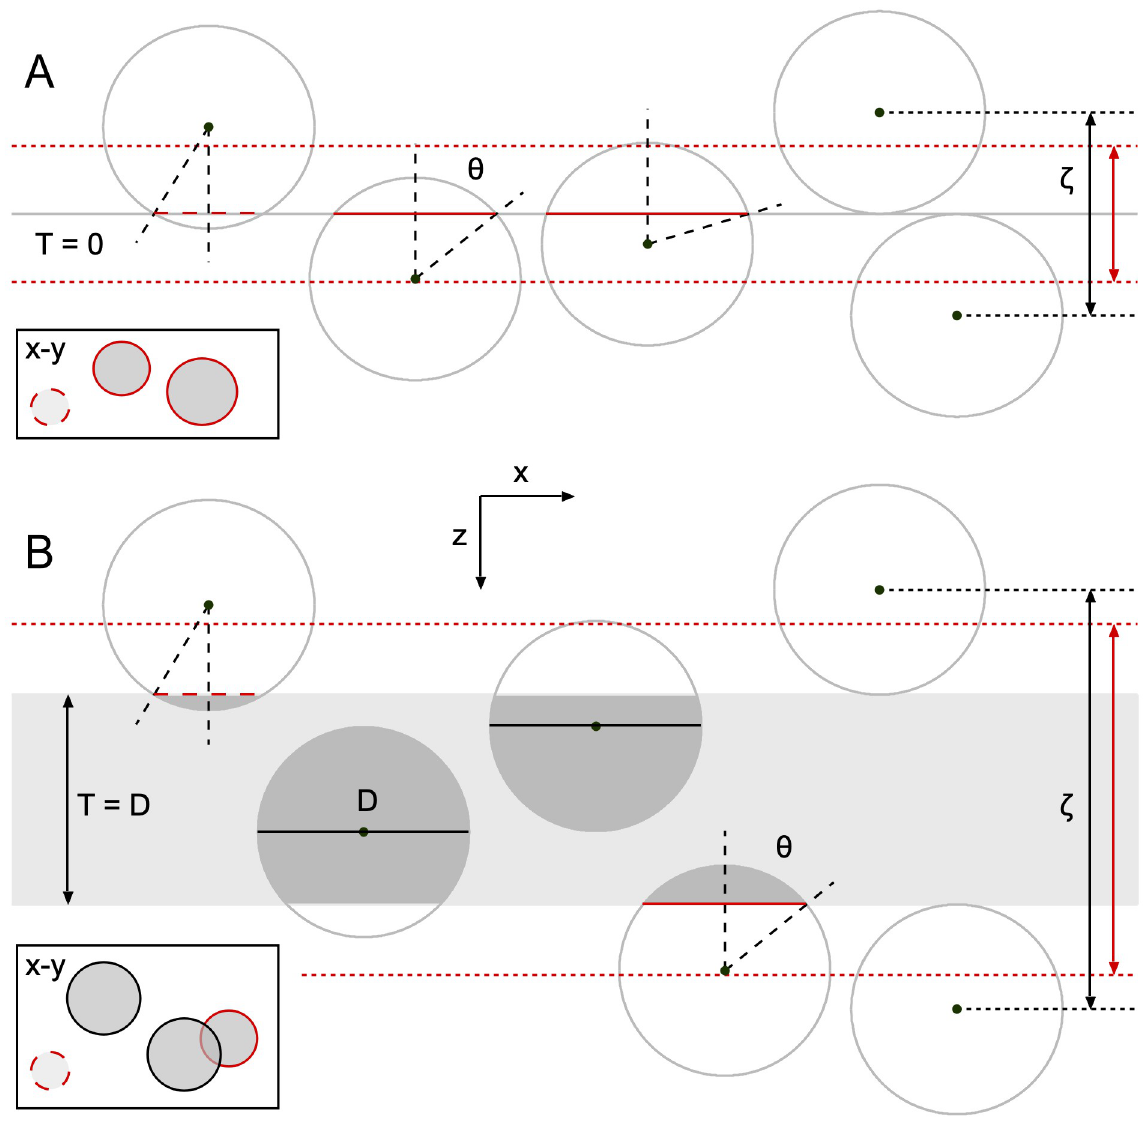
Fig 1. Illustration of observed circular profiles when spherical particles are orthogonally viewed from above a planar or thick section. A. Side view of a planar section (T = 0; gray line) transecting spherical particles (red solid lines). For simplicity, all particles have the same 3D diameter (D). Particles with their center above/below the section within a distance D/2 are observed as circular ‘caps’ in a horizontal projection (inset rectangle, top view, red circles) with apparent diameter d < D, where d = D � sin θ and θ is the cap angle (black dashed lines) that takes on values between 0˚, where d = 0, and 90˚, where d = D. Hence, those particles appearing within the projection have their center confined within a depth z = D (black double-headed arrow). However, due to experimental limitations, the smallest caps (with small θ ) are not apparent, i.e. lost (red dashed lines). To account for lost caps, the Keiding model sets a minimum limit on θ ( ϕ ) such that caps are observed in the projection only if ϕ < θ < 90˚ [49]. In this case, z = D � cos ϕ (red double-headed arrow; Eq 2). For planar sections, there are no projection overlaps (inset) and the total area fraction (AF) of the projections approximately equals the 3D volume fraction (VF) of the particles so long as there are relatively few lost caps. Because all particle centers fall above/below the planar section, all particles are considered caps. B. Same as A for a thick section (T = D). In this case, particles with their center within the section have a circular projection with d = D (black circles) and z = T + D � cos ϕ . For thick sections and a high particle density, there are usually projection overlaps (inset) that make counting/outlining the projections more difficult; moreover, AF > VF, a condition known as